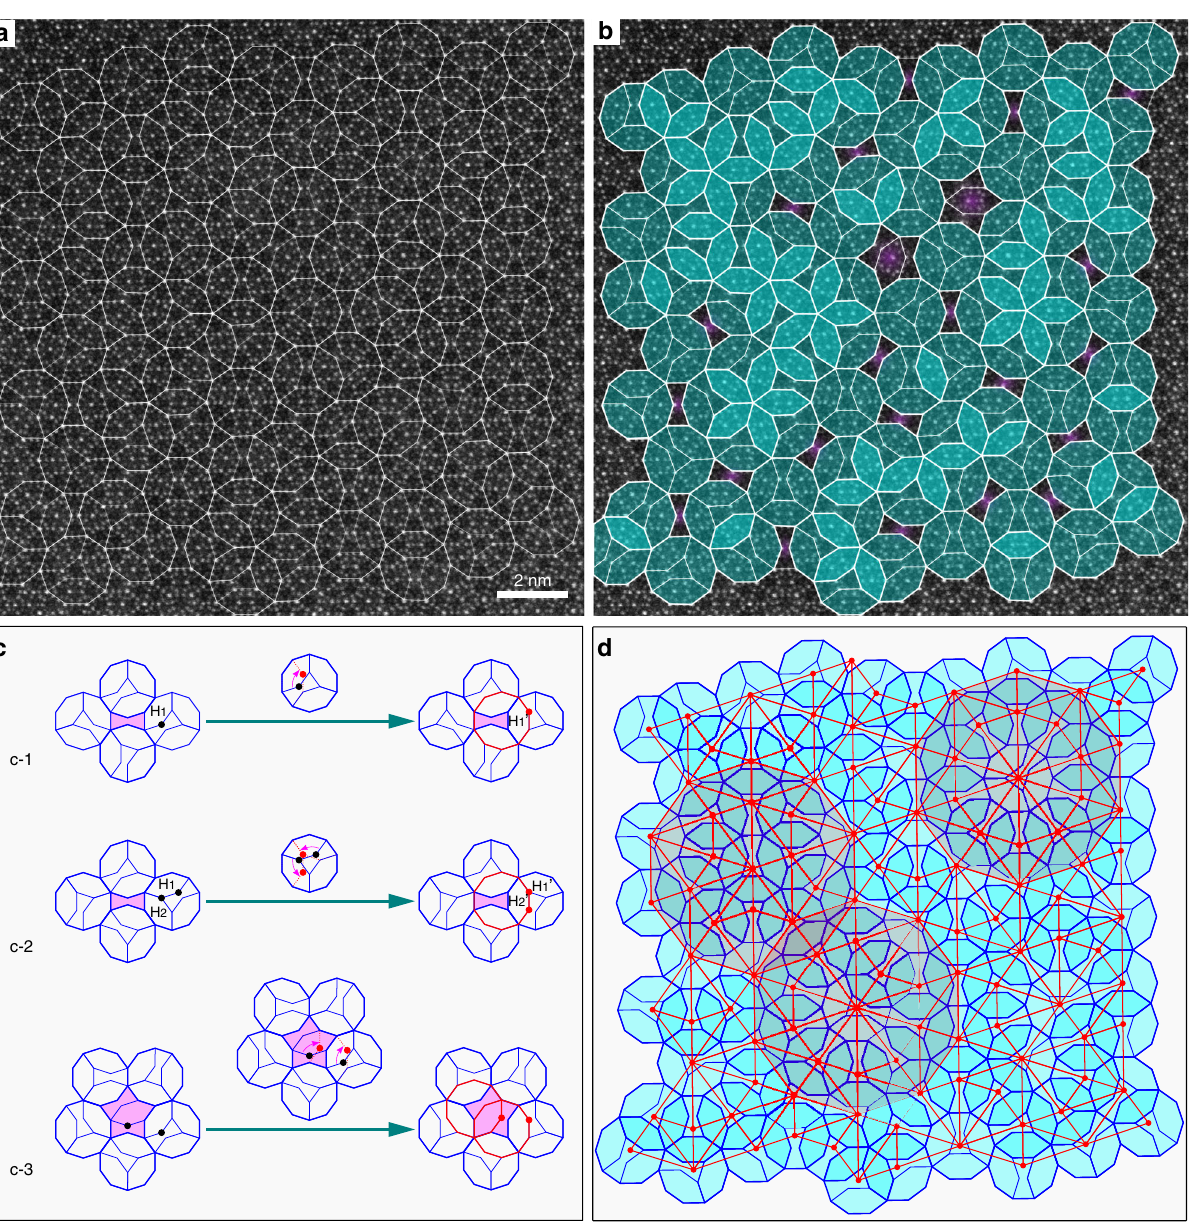
Fig. 2 Covering based on the Lück decagon. a HAADF-STEM image along the tenfold axis of decagonal Al 74 Cr 15 Fe 11 with a Lück-decagon covering superposed. b The Lück decagons are shaded blue to clearly show some defective areas (6.1% of the total area) marked in purple. c The action of phason fl ipping to eliminate the defects (purple area) visible in b . One or two more Lück decagons are generated in the right column with the disappearance of the purple defects in the left column, after the change of few fl at hexagonal (H) tiles. d If the centers of the Lück decagons (red dots) are connected by lines a triangle tiling is created, which resembles the Tübingen-triangle tiling (TTT). For the TTT typical decagonal areas are shaded in transparent red. In the ideal TTT the straight lines would not be is somewhat more complex than that in Fig. 2c-1. For example, to The purple BT gap in the left column of Fig. 2c-1 is eliminated eliminate defect of purple BT in Fig. 2c-2 in the left column and by being included in a quasi-unit-cell of D 3H + 1BT decagon to also maintain the quasiperiodic repeating of the nearby quasi- (outlined red) in the right column, after the change of H 1 tile in unit-cell of D 3H + 1BT tiles without gaps, the change of two vertexes the left column to the H 1 ′ tile in the right column. In fact, the change from H 1 to H 1 ′ tile is simply realized through the phason of tiles is needed, and resulting in the change of H 1 and H 2 tile in fl ipping by changing only one vertex (namely, from black spot to the left column to the H 1 ′ and H 2 ′ tile in the right column. Occasionally, the change of three atomic positions is needed (see the red spot, as marked by a red arrow in the middle), which was in Supplementary Fig. 1a). For the defect of S tiles in Fig. 2c-3 in observed experimentally through in situ high resolution trans- the left column, two atomic positions are changed and create two mission electron microscopy (TEM) observations 22,23 . Conse- quently, the defect of purple BT in the left column is mended and more D 3H + 1BT tiles (also see another example in Supplementary one more quasi-unit-cell is accordingly added, as shown by the Fig. 1b), rather than one more D 3H + 1BT tile for eliminating BT- red D 3H + 1BT in the right column. Sometimes, the phason fl ipping type defects mentioned above.